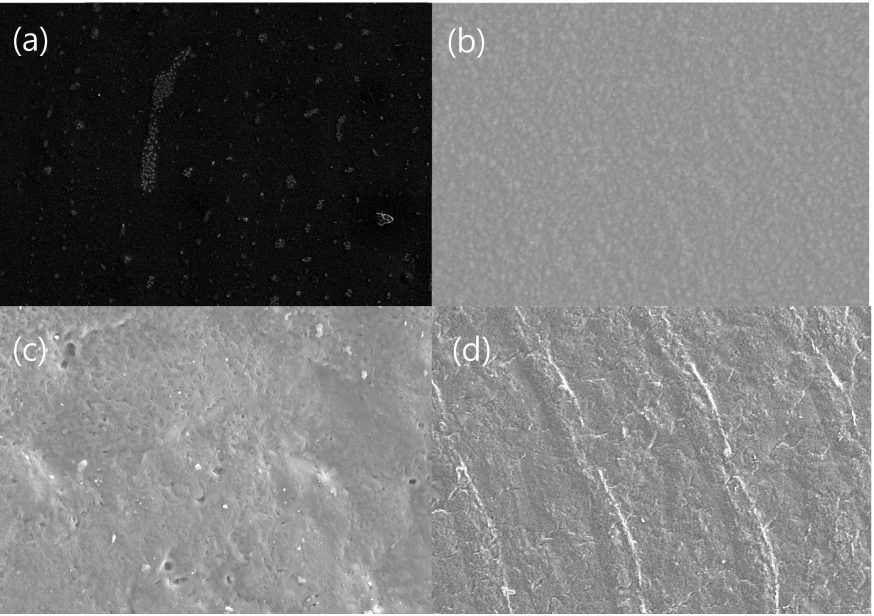
Figure 13. SEM images of the APA surface with different contents of h-BN; ( a ) 10 wt% of non-surface- treatment h-BN, ( b ) 3 wt%, ( c ) 6 wt%, ( d ) 10